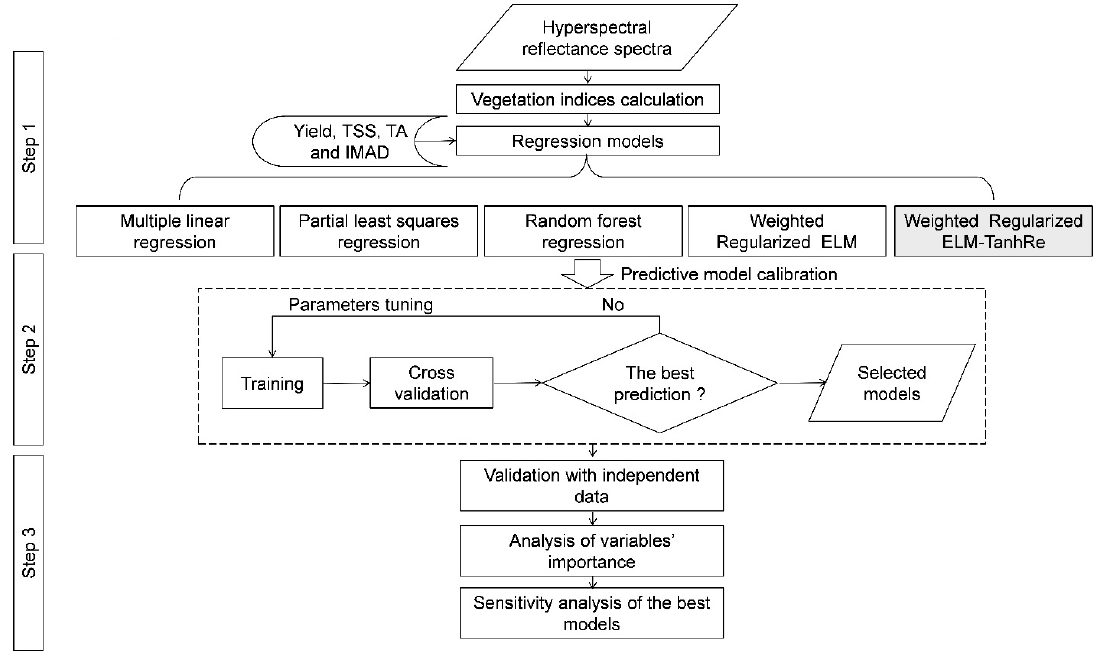
Figure 3. Flowchart of the berry yield and quality prediction process using canopy-level hyperspectral reflectance spectra. Grey box indicates the developed method in this study.